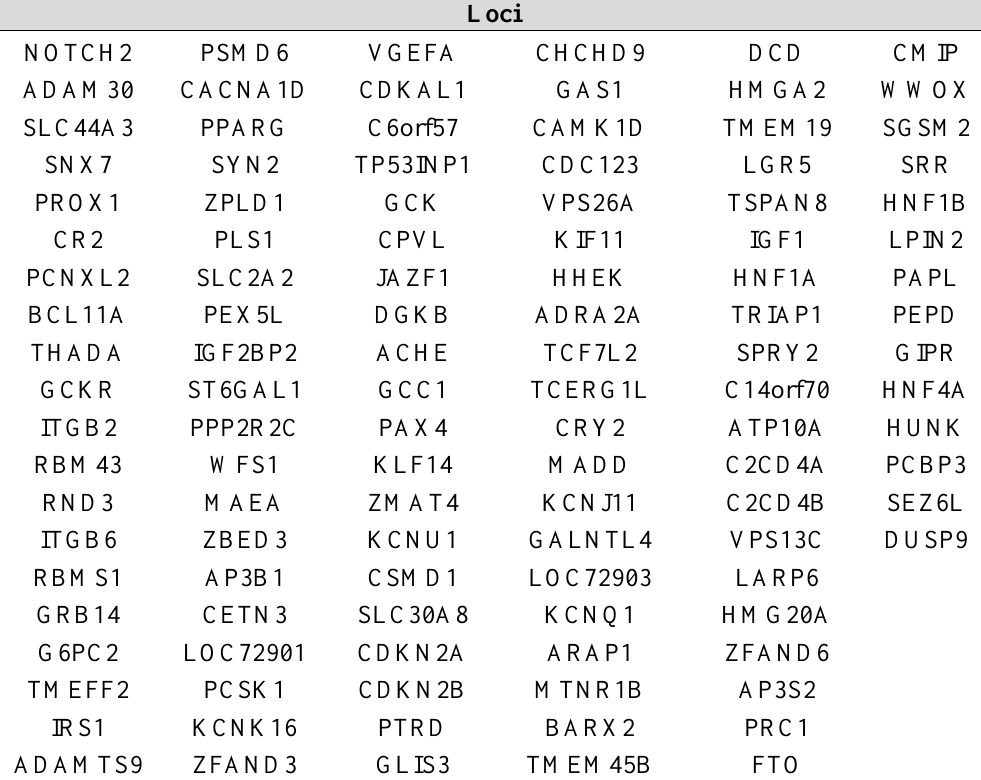
Table 1. Loci for T2DM-related traits identified by GWAS (in order of gene region).